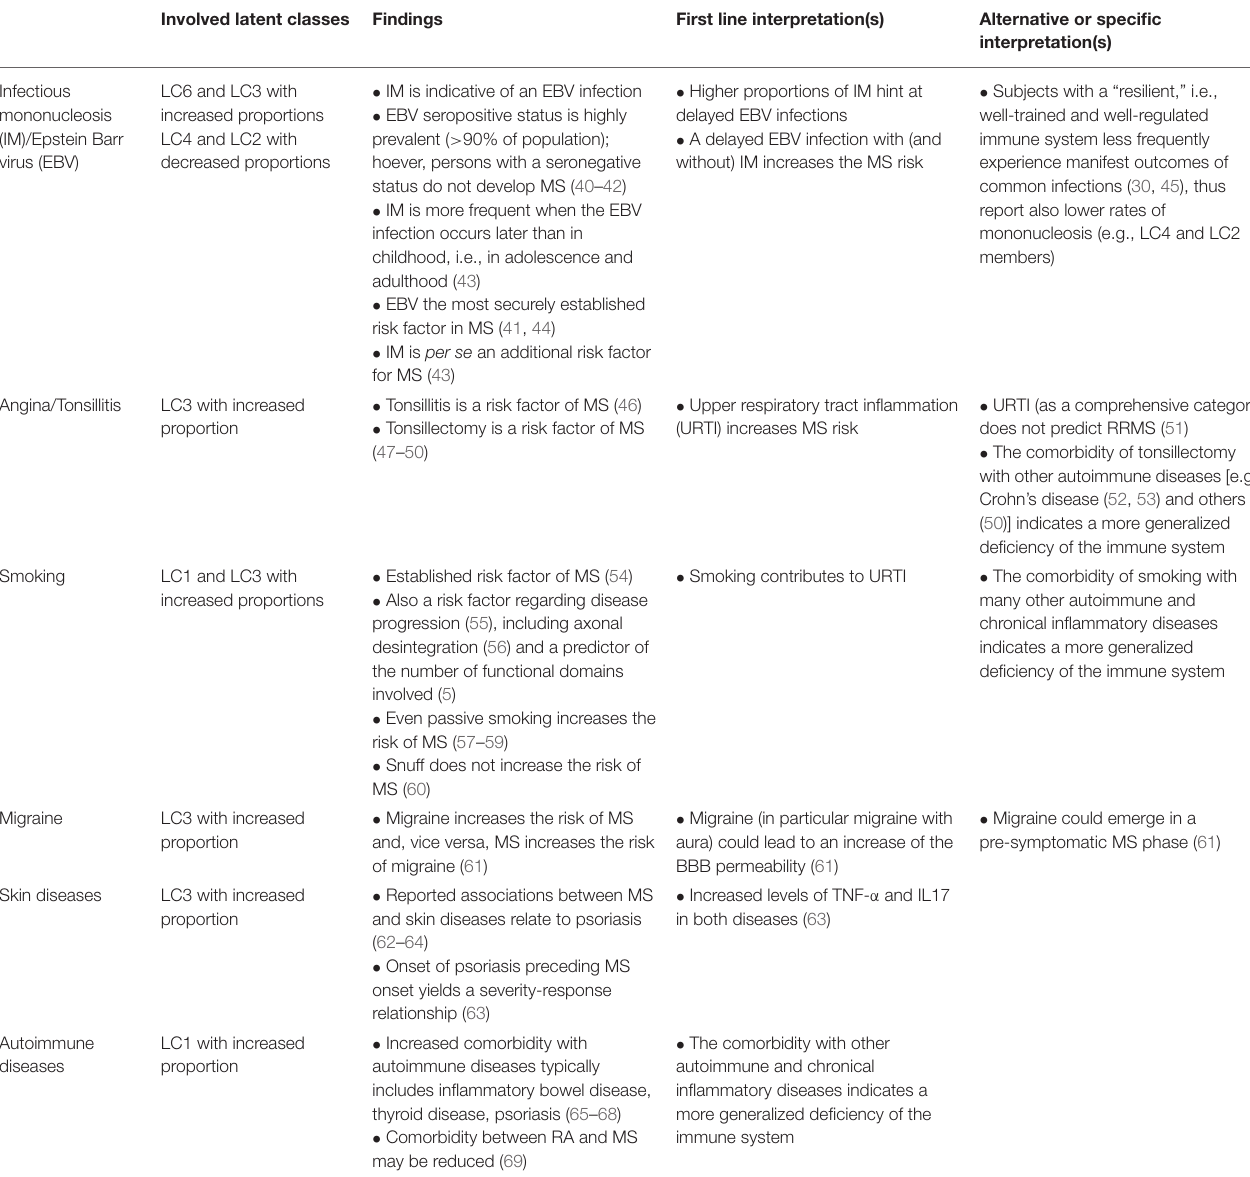
TABLE 5 | Overview of risk factors related to MS onset symptom classes. Involved latent classes